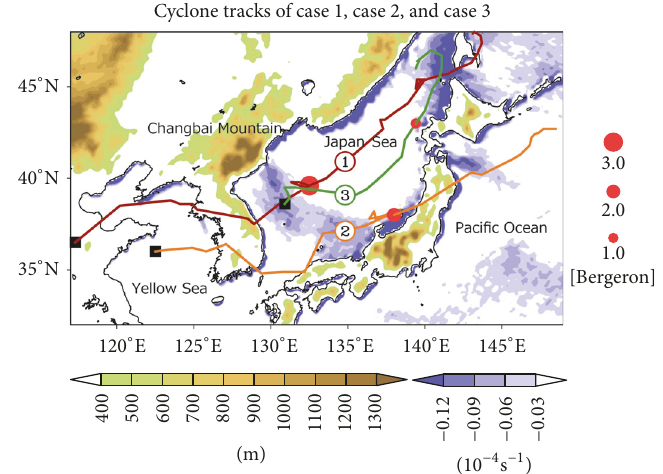
Figure 6: Tracks of the three synoptic-scale cyclones extracted as typical cases. The location of the initial appearance of a cyclone is denoted by blue rectangles. The locations of explosive cyclones when their rates of development reached the maximum are indicated by red circles. The size of the circles denotes the magnitude of the maximum deepening rate (hPa hr −1 ). The topography and climatological mean 925 hPa horizontal wind divergence for December are also shown. The shading interval for wind divergence is 3 × 10 −6 s −1